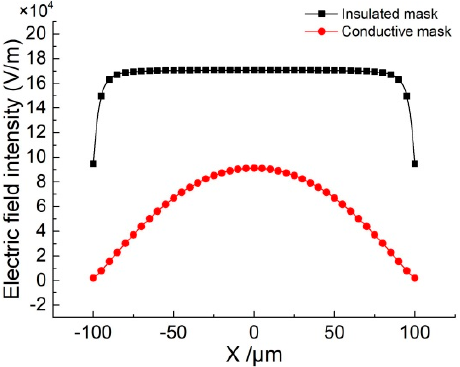
Figure 3. Electric field intensity on the workpiece surface using different masks.